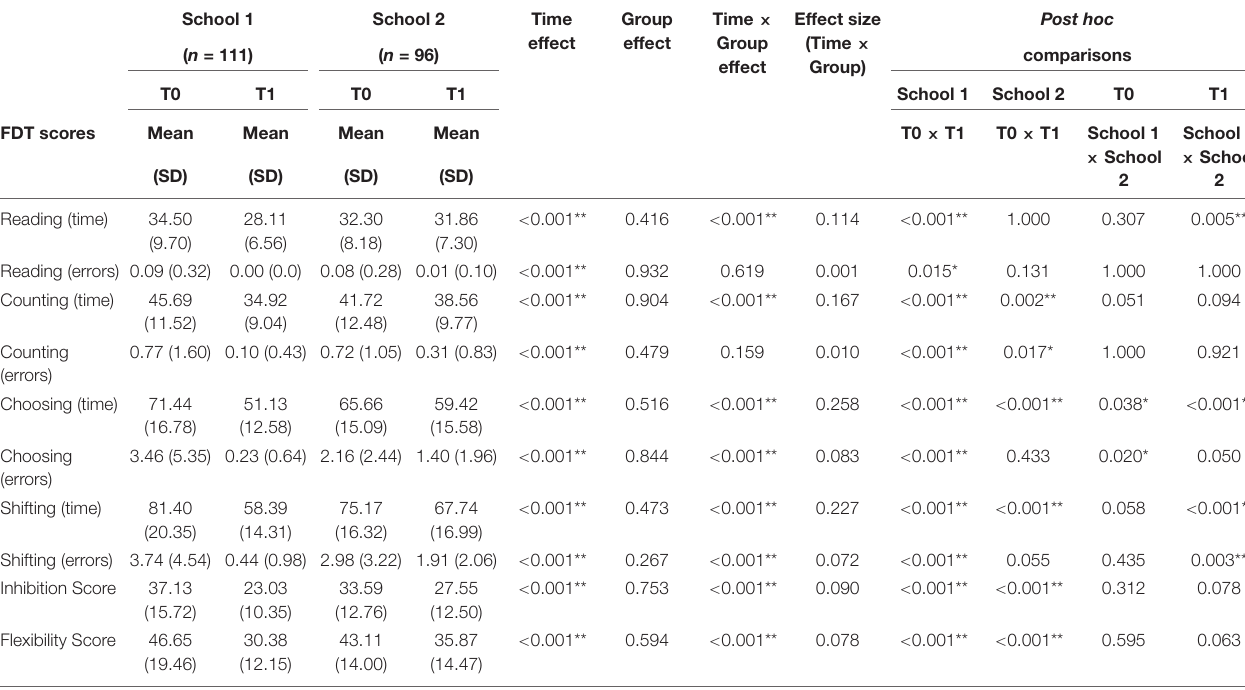
TABLE 1 | Comparisons between school 1 and school 2 for FDT scores in T0 (baseline) and after 8 weeks (T1). School 1